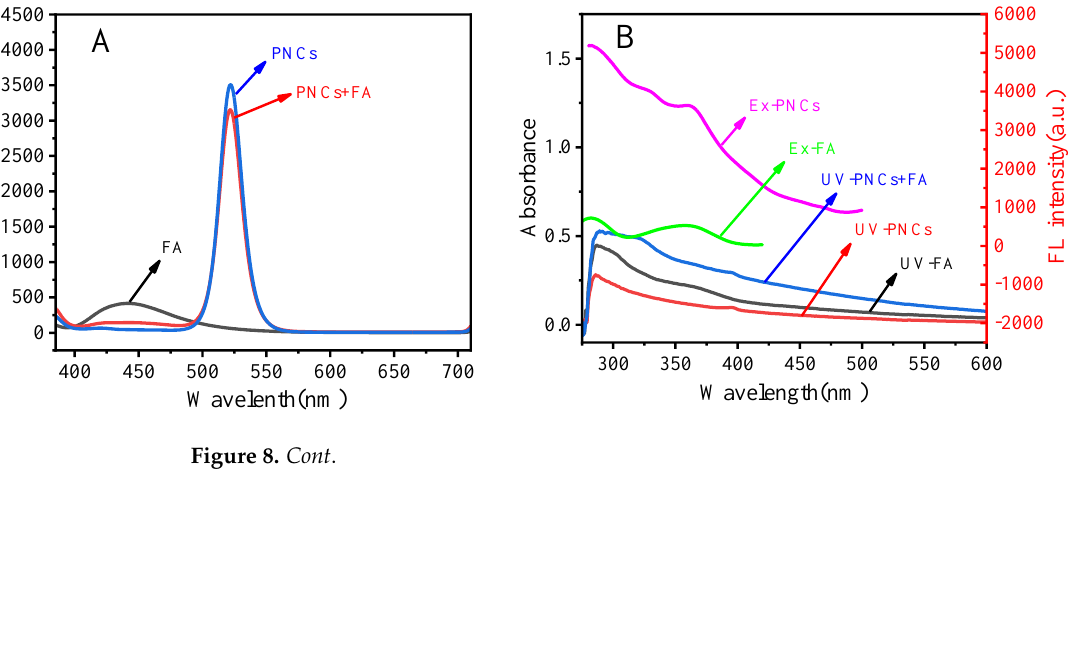
Table 2. PL decay parameters of the CsPbBr 3 /Cs 4 PbBr 6 PNCs and CsPbBr 3 /Cs 4 PbBr 6 PNCs/FA mixture.